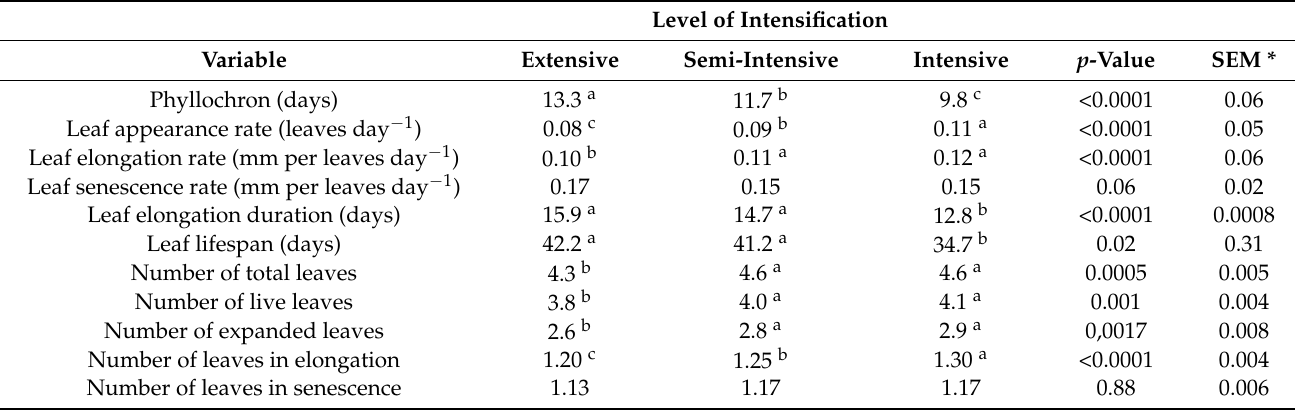
Table 2. Morphogenic variables, number of leaves, leaf elongation duration, and senescence rate of marandu palisadegrass ( Urochloa brizantha ‘Marandu’) pastures under different levels of intensification.